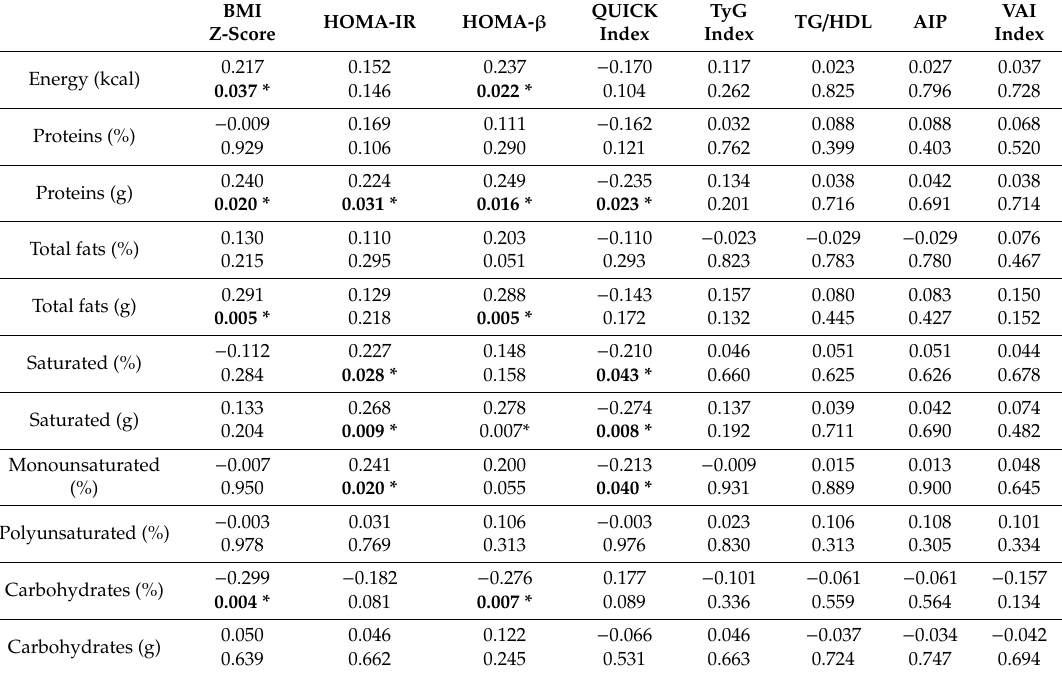
Table 5. Association between macronutrients and cardiometabolic risk factors (ratio coe ffi cient and statistical significance. VAI, visceral adiposity index. p -values ≤ 0.050 are shown in